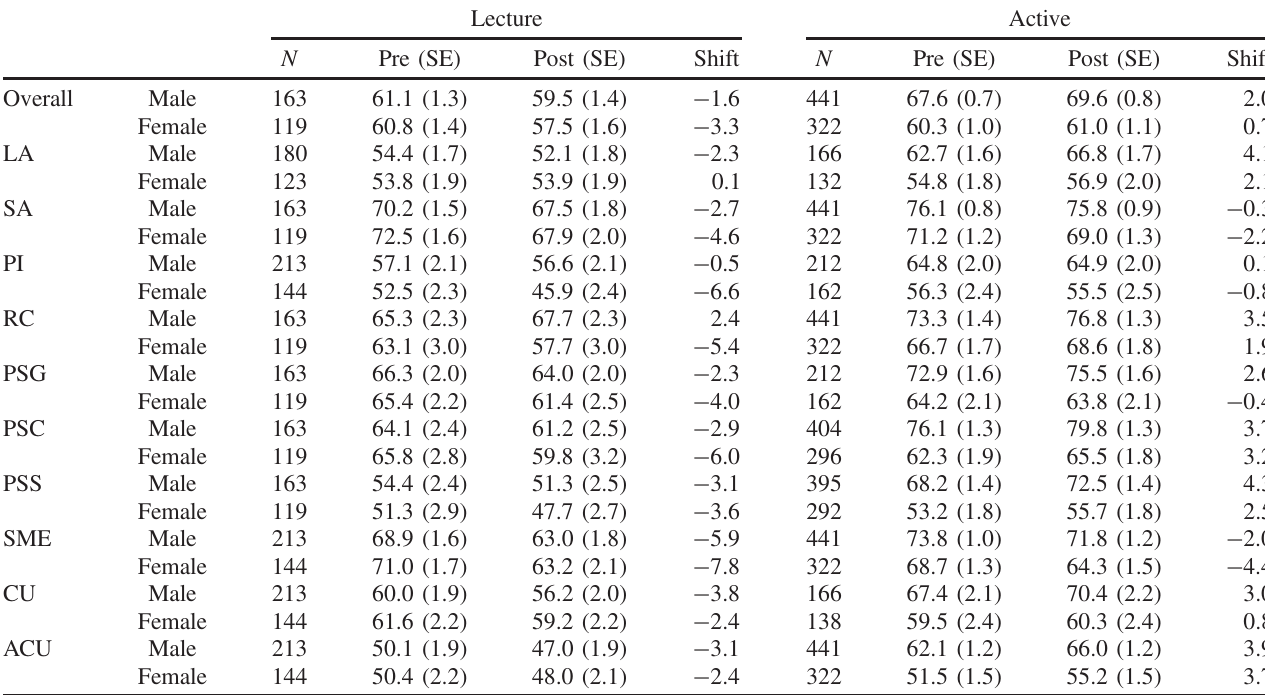
TABLE VII. Detailed descriptive statistics among males and females for the Fall-only CLASS. SE indicates Standard error.